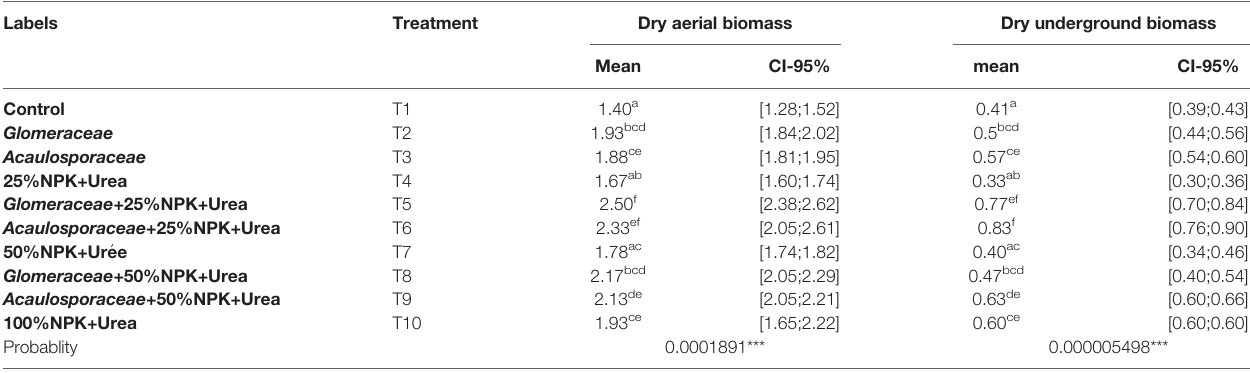
TABLE 3 | Effect of mycorrhizal fungi on biomass produced in the greenhouse. Labels Treatment